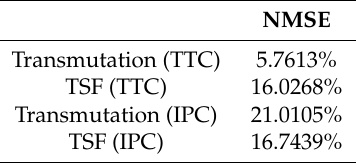
Table 2. Normalized mean squared error for transmutation and TSF modeling